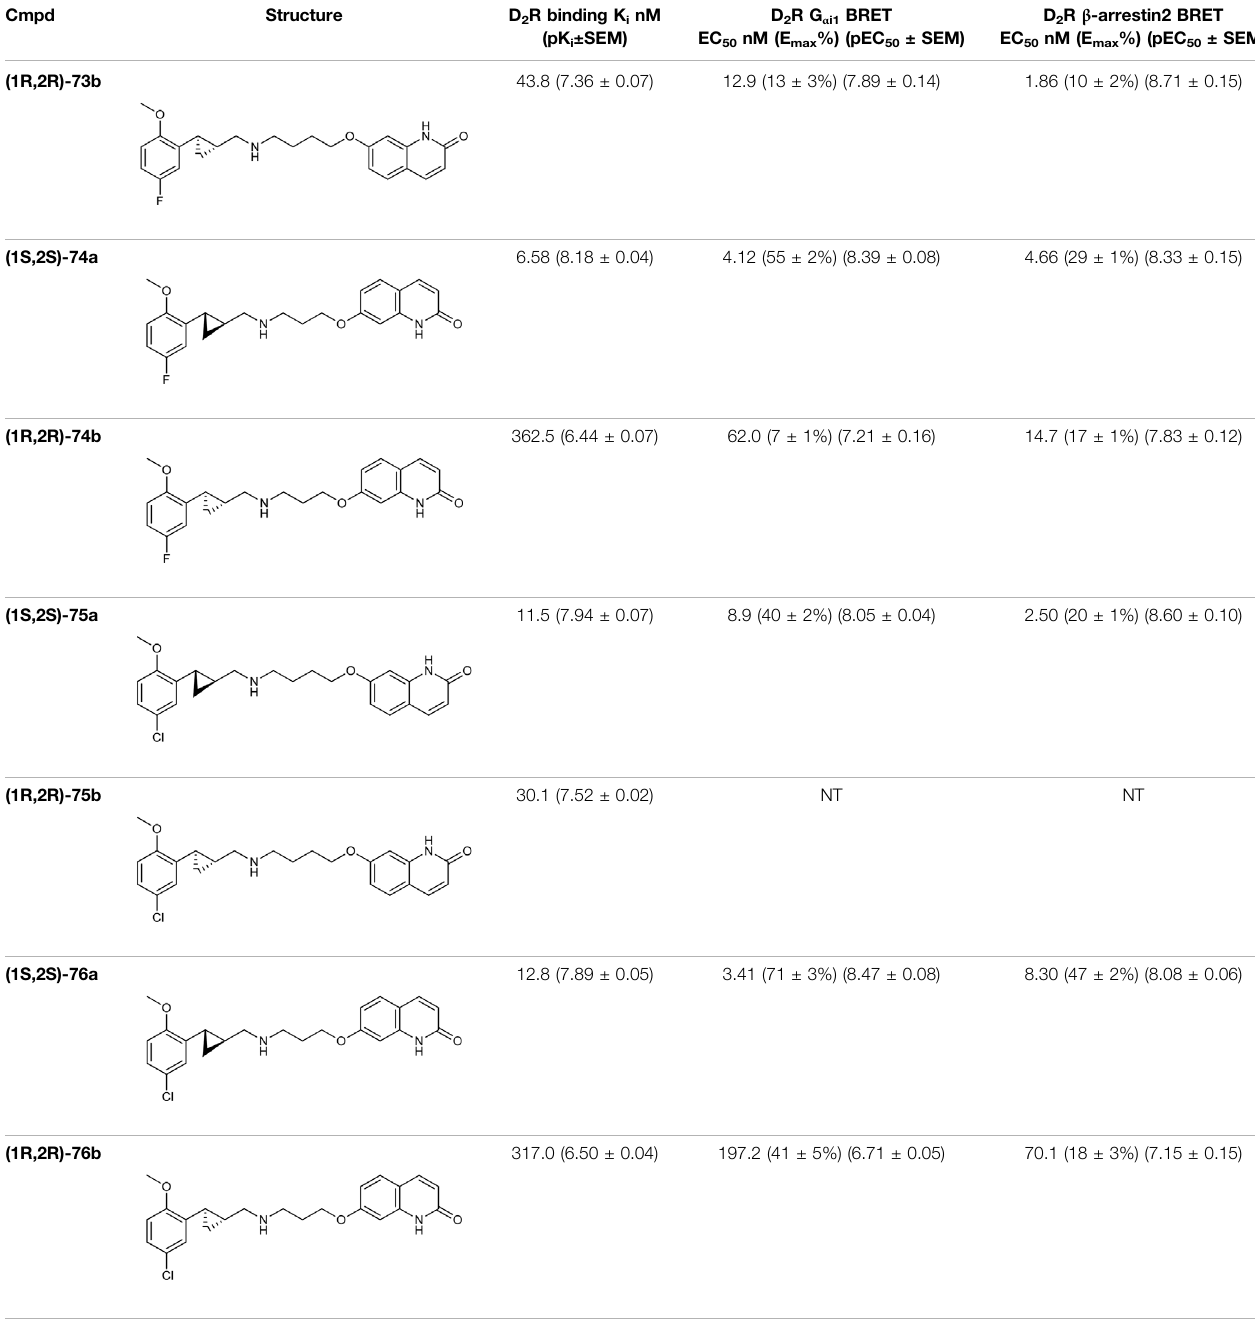
TABLE 5 | ( Continued ) Pharmacological pro fi ling of compounds (D2R binding and functional activity) (Yan et al., 2021).